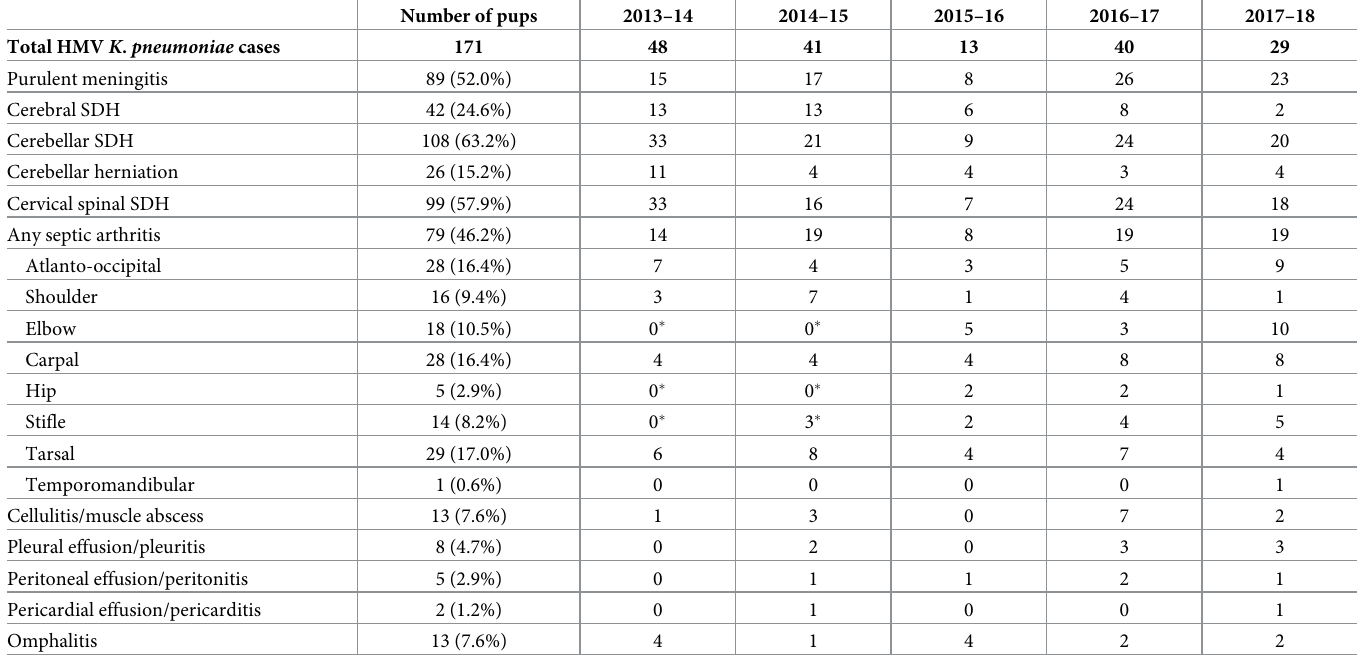
Table 4. Summary of common gross necropsy findings in hypermucoviscous (HMV) K . pneumoniae cases in New Zealand sea lion ( Phocarctos hookeri ) pups at Sandy Bay, Enderby Island;